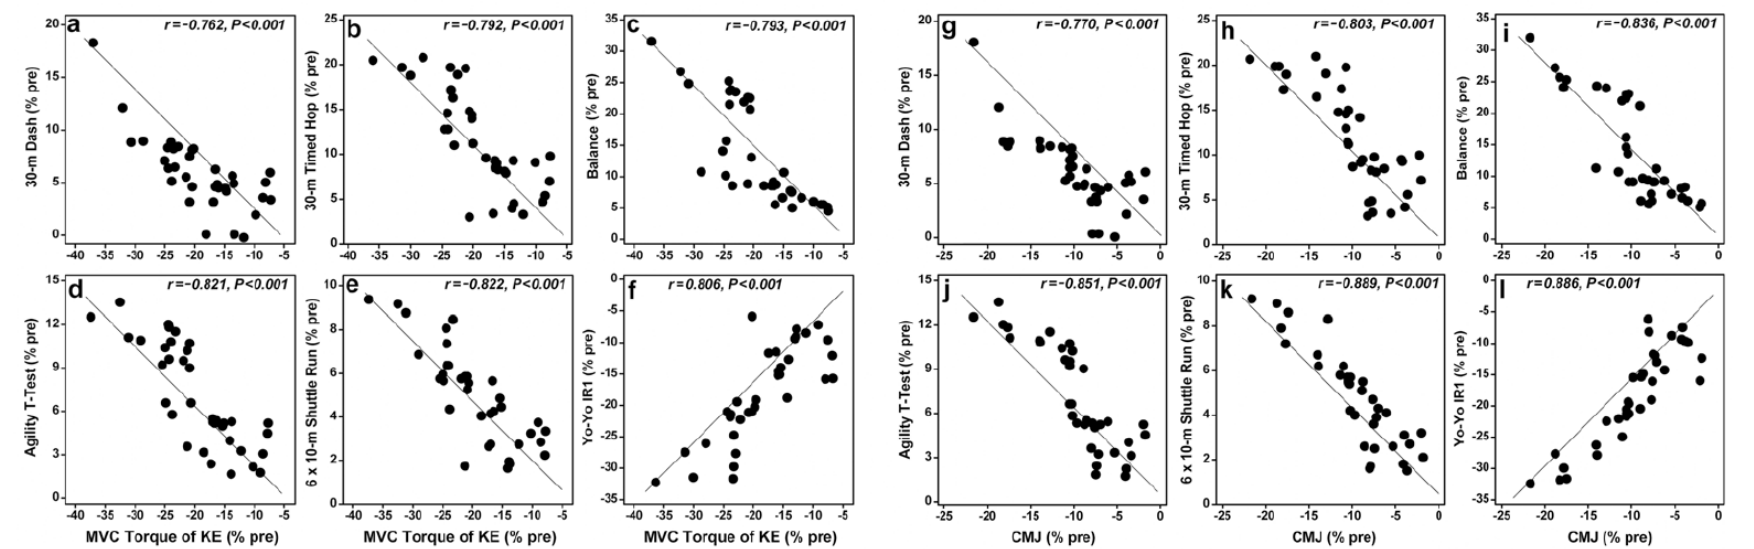
Figure 5. Correlations between the magnitude of normalized changes (% pre) in maximal voluntary isometric contraction torque of knee extensors (MVC-KE) or countermovement jump (CMJ) at 1 d after one Loughborough Intermittent Shuttle Test (LIST) and the normalized changes in 30-m dash (MVC-KE: a , CMJ: g ), 30-m timed hop test (MVC-KE: b , CMJ: h ), balance with eyes closed under unstable surface (MVC-KE: c , CMJ: i ), agility t -test (MVC-KE: d , CMJ: j ), 6 × 10-m shuttle run (MVC-KE: e , CMJ: k ) and Yo-Yo Intermittent Recovery Test level 1 (MVC-KE: f , CMJ: l ) at 1 d after LIST with one, three, and six LIST groups combined ( n = 36). For each figure, r value based on Pearson correlation coefficient and its significance, and a regression line are included.